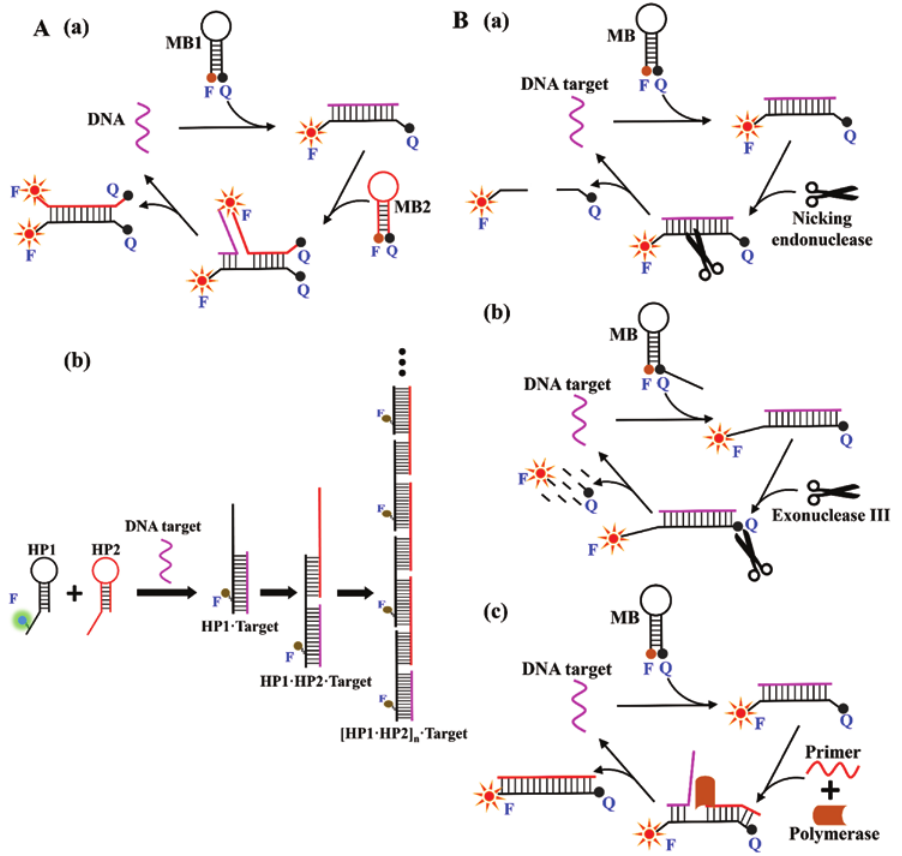
Figure 6: Schematic of strategies used in HDP-based amplification platforms. (A) Enzyme-free schemes using CHA (a) and HCR (b) and (B) enzyme-assisted methods with the employment of different enzymes: nicking endonuclease (a), exonuclease III (b), and polymerase